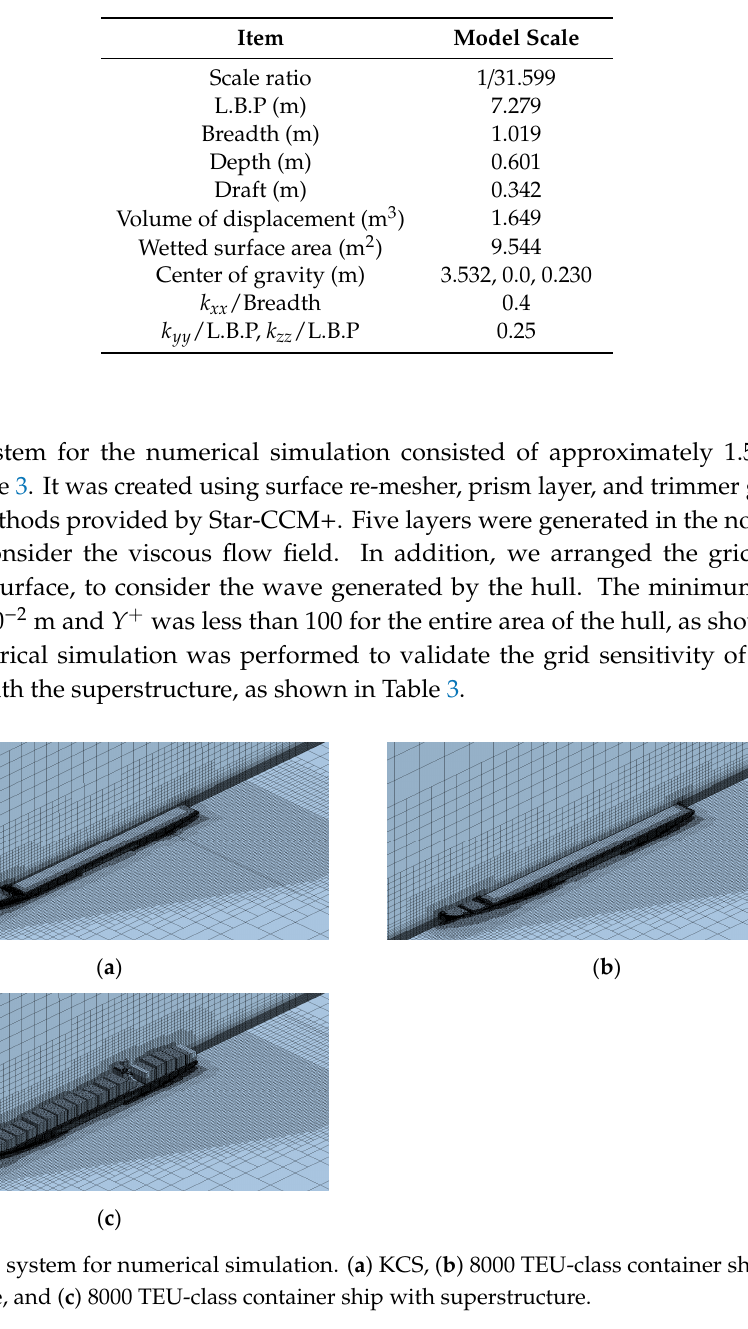
Table 2. Principal dimensions of KCS (center of gravity means (from A.P. to F.P., centerline, from baseline to upward)).